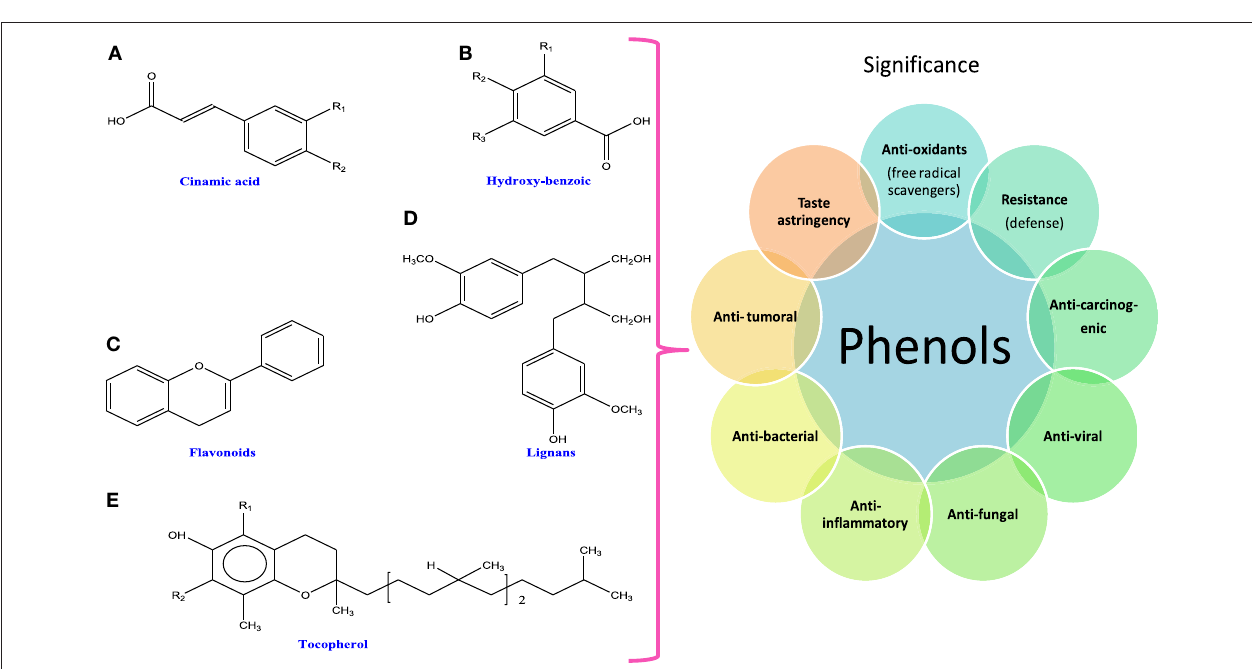
FIGURE 2 | Chemical structures and significance of polyphenols: (A) cinamic acid, (B) hydroxy-benzoic acid, (C) flavonoids, (D) lignans, and (E) tocopherols obtained from different cyanobacteria and algae.